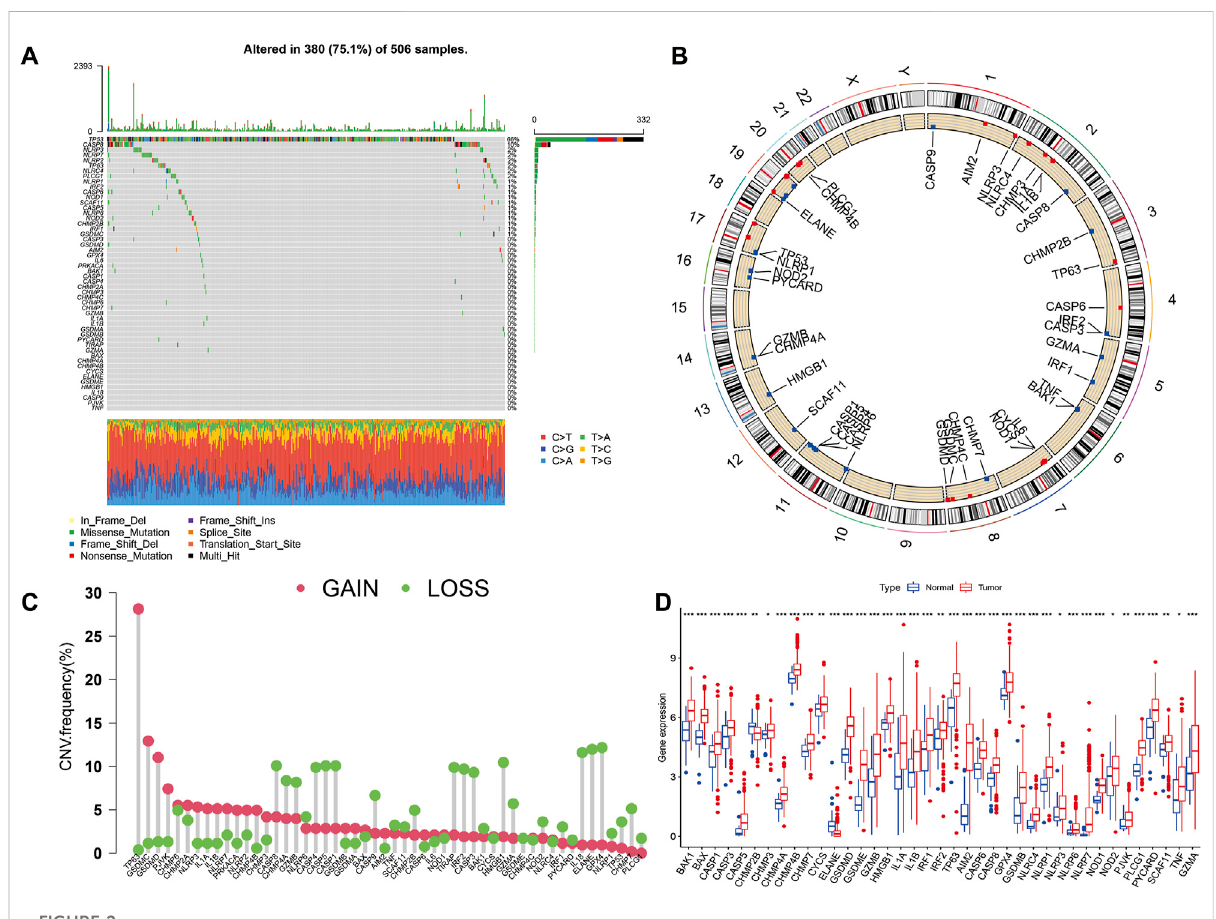
FIGURE 2 Expression and variation of pyroptosis regulators in HNSCC. (A) Mutation frequency of 52 PRGs for 506 HNSCC patients. (B) The location of PRGs on chromosomes in TCGA cohort. (C) Frequency of CNV alteration in PRGs. Green: missing frequency; red: ampli fi ed frequency. (D) The expressions of 52 pyroptosis regulatory factors differ between HNSCC and normal tissues. The upper and lower ends of the boxes represent the interquartile range of values. The lines in the boxes represent the median value. Tumor, red; Normal, blue. Statistically signi fi cant values are represented by asterisks corresponding to * p < 0.05, ** p < 0.01, *** p < 0.001 and **** p <